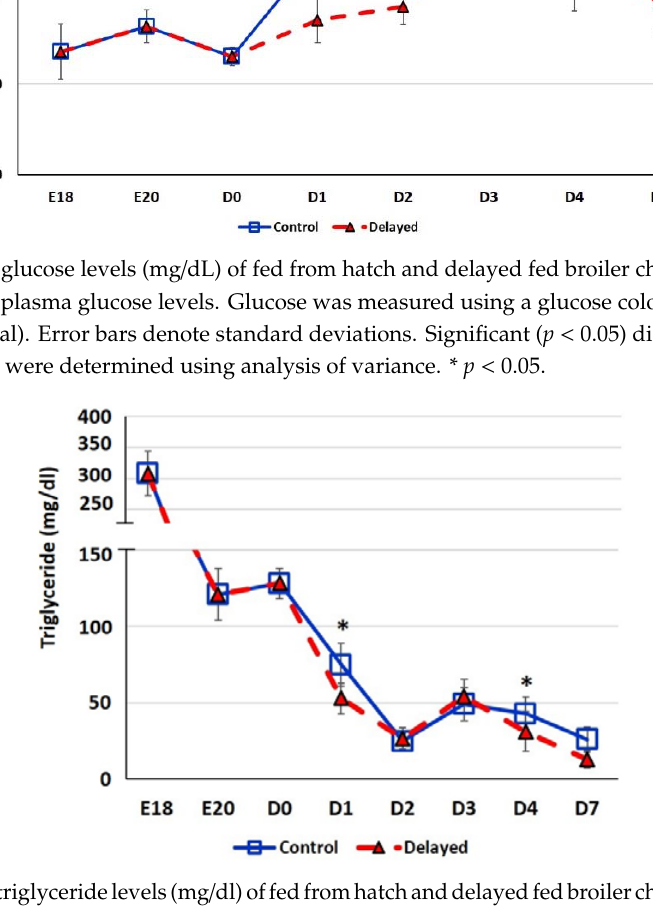
Figure 3. Plasma triglyceride levels (mg/dl) of fed from hatch and delayed fed broiler chicks. Mean (n = 6 males/treatment) plasma triglyceride levels. Triglyceride was measured using a triglyceride colorimetric assay kit (Cayman Chemical). Error bars denote standard deviations. Significant ( p < 0.05) differences between treatment groups were determined using analysis of variance. * p < 0.05.